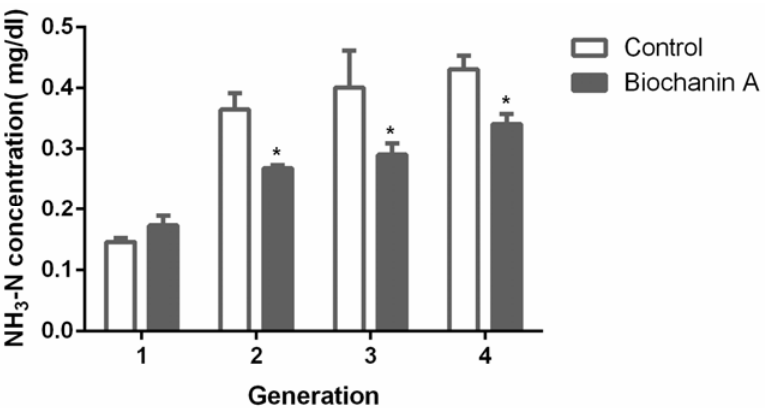
Figure 1. The effect of biochanin A on NH 3 ‐ N concentration in an anaerobic culture. Treatments included controls (only dimethyl sulfoxide (DMSO)) and anaerobic medium with exogenous addition of biochanin A. Asterisks (*) indicate a significant difference between treatments ( p < 0.05). Error bars represent SEM.